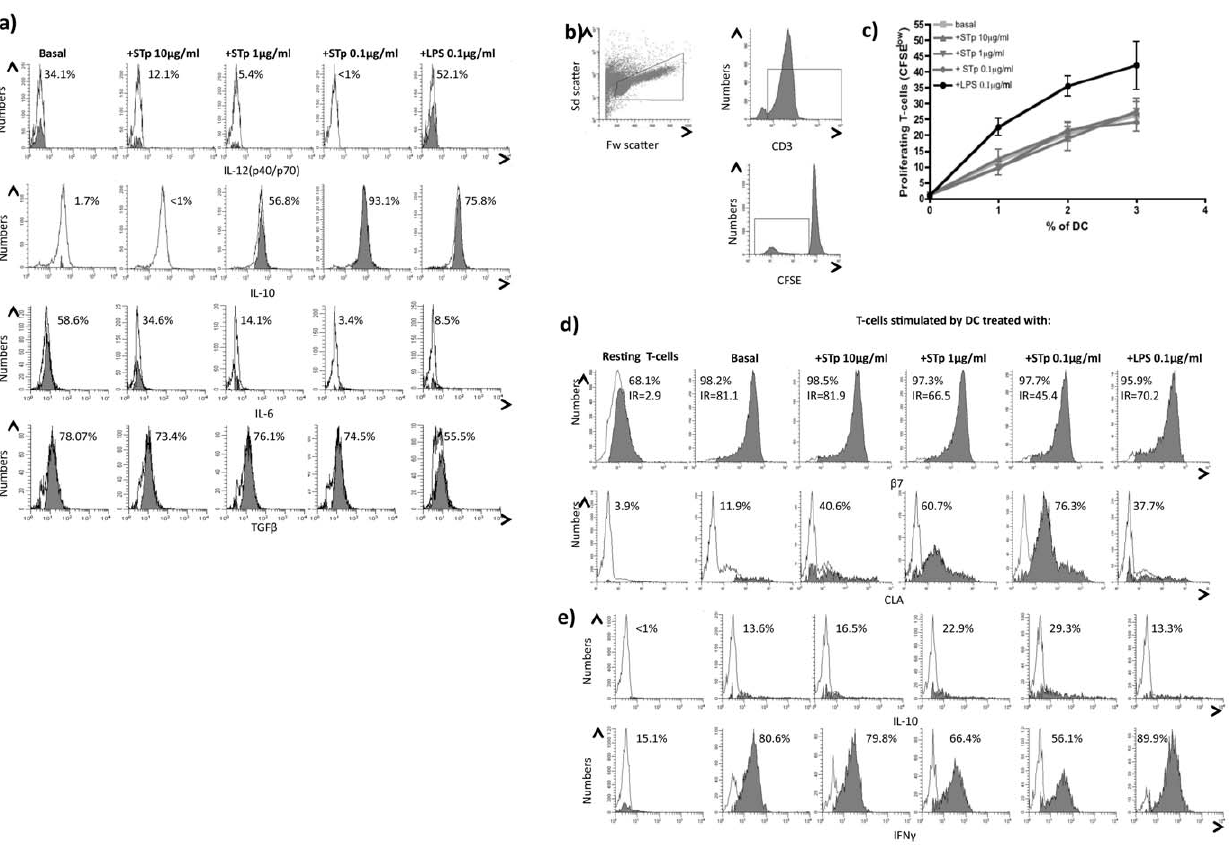
Figure 2. STp induced i) regulatory cytokines in blood enriched DC and ii) stimulated T-cells, which acquired a skin homing profile. a ) Intracellular ongoing cytokine production of IL-12(p40/p70), IL-10, IL-6 and TGF b in blood DC of healthy controls after 24 hours stimulation with STp (10 m g/ml, 1 m g/ml and 0.1 m g/ml) or LPS (100 ng/ml) compared to a basal culture. Closed histograms represent the percentage of positive cells assessed by intracellular cytokine staining and SED normalized subtraction from antibody stained cells cultured in the absence of monensin.